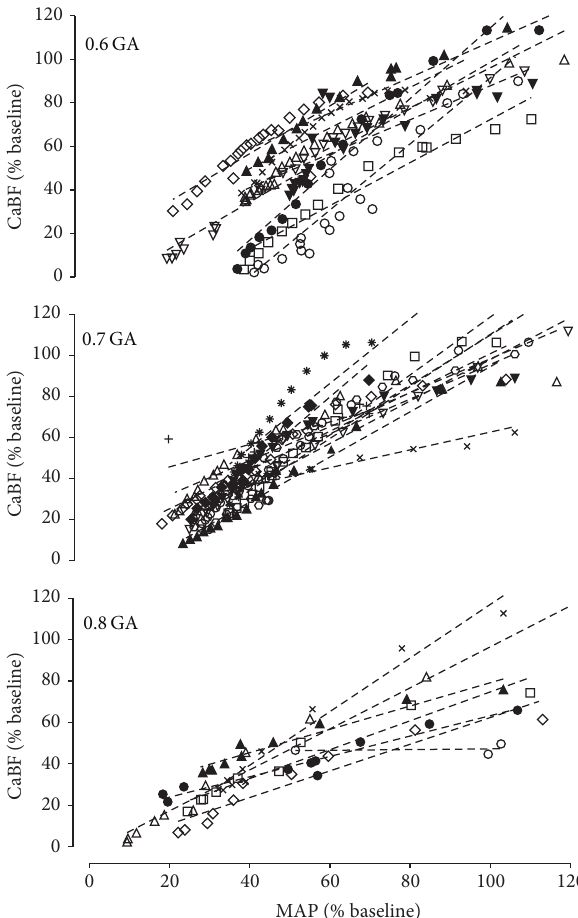
Figure 3: The relationship between changes in mean arterial pres- sure (MAP, % baseline) and carotid blood flow (CaBF, % baseline) from the minute MAP fell below baseline until the end of occlusion in 0.6 gestation (0.6GA), 0.7 gestation (0.7 GA), and 0.8 gestation (0.8 GA) fetuses. Different symbols represent individual animals, while the dotted lines indicate their regression relationship. All fetusesshowedapositivewithin-subjectsrelationshipbetweenmean arterial pressure and cephalic perfusion during the development of hypotension ( 𝑃 < 0.01 , 𝑅 2 = 0.91 , 𝑛 = 28 ). The predictor variable gestational age was not